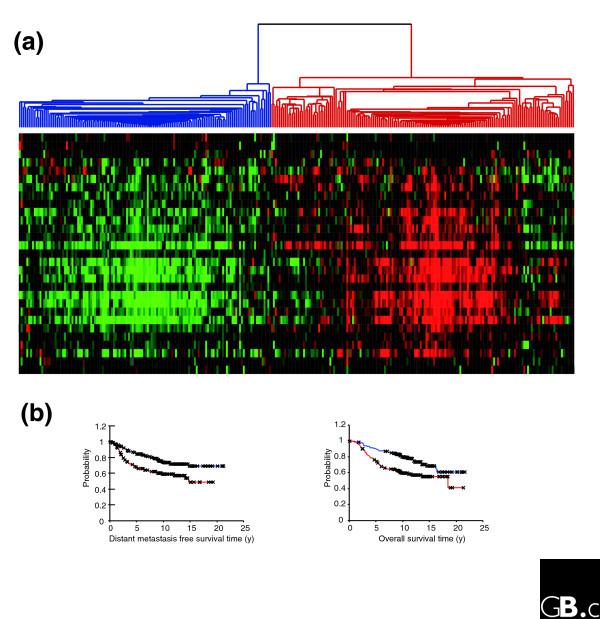
Interferon response gene expression in early stage breast cancer (a) The expression values of genes in the 'interferon response gene set' were extracted from a published expression study of 295 early stage breast cancers from the Netherlands Cancer Institute [35]. Genes and samples are organized by hierarchical clustering. The tumors segregated into two groups defined by high (red) or low (blue) expression levels of 29 genes matching the 'interferon response gene set'. (b) Correlation of interferon response with distant metastasis free and overall survival. Kaplan-Meier curves for the clinical outcomes of indicated tumors exhibiting high (red curve) and low (blue curve) interferon responses are shown.